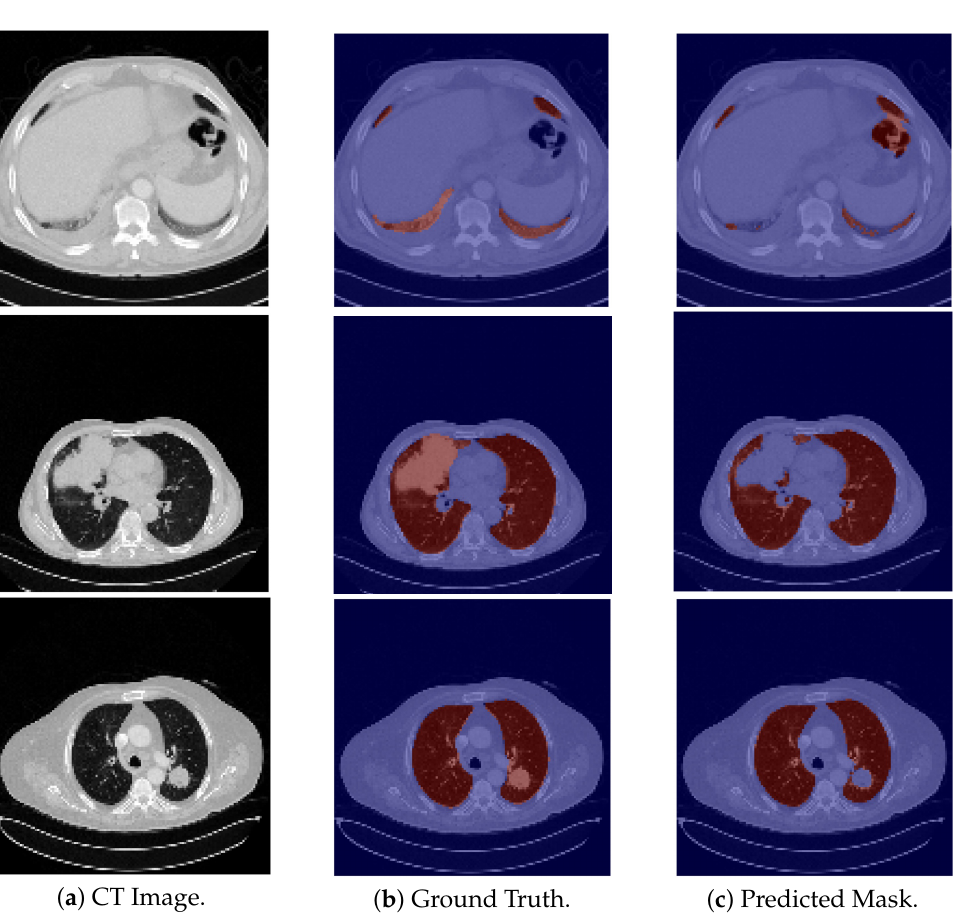
( a ) CT Image. ( b ) Ground Truth. ( c ) Predicted Mask. Figure 4. Examples of VESSEL12 images for which the model produces good segmentation masks.